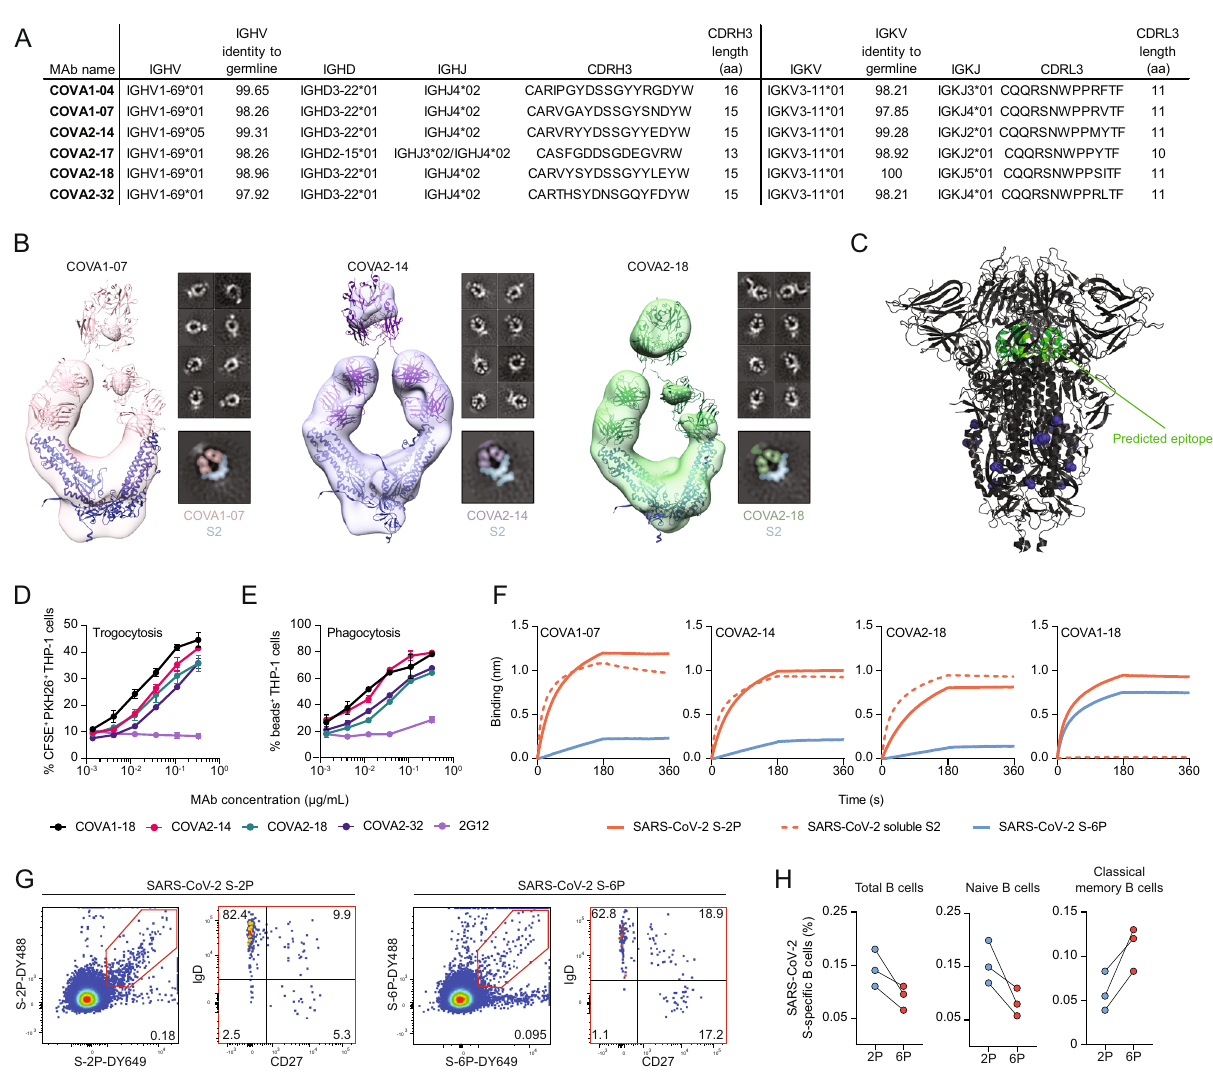
Fig. 4 | A public antibody class recognizes lesser stabilized epitopes on the S2 domainofSARS-CoV-2S.A CharacteristicsofIGHV1-69/IGKV3-11MAbsisolatedin a previous study 13 . B 3D reconstructions of COVA1-07 (pink), COVA2-14 (purple), and COVA2-18 (green) complexed with solubleS2. The modelsfor IgG (PDB 1HZH) and the S2 domain (generated from PDB 7JJI) are docked into each density map. Individual representative 2D class averages of COVA MAbs in complex with S2 are shown to the right of each 3D reconstruction. C The predicted epitope (green) of COVA1-07, COVA2-14 and COVA2-18 MAbs on S2 in the context of SARS-CoV-2 S with 3 RBDs in the down conformation (PDB 7JJI). The purple spheres indicate the location ofthe additional proline substitutions found in the S6-P construct(F817P, A892P, A899P, A942P). ( D – E ) Antibody-dependent cellular trogocytosis ( D ) and antibody-dependent cellular phagocytosis ( E ) assays for COVA MAbs and control